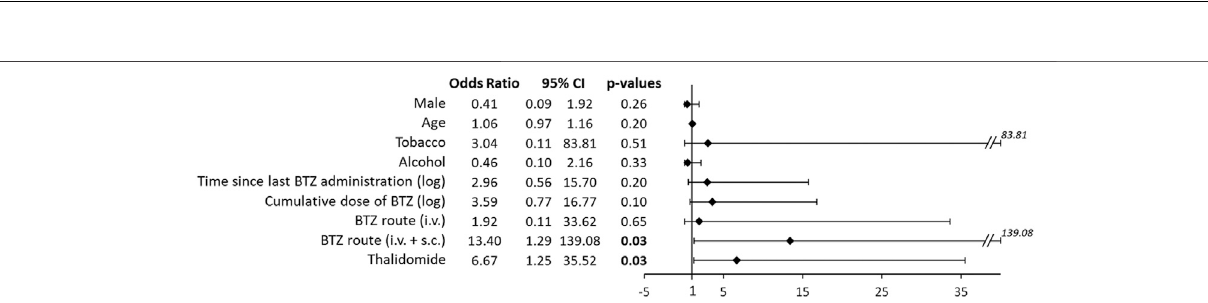
Frontiers in Pharmacology |